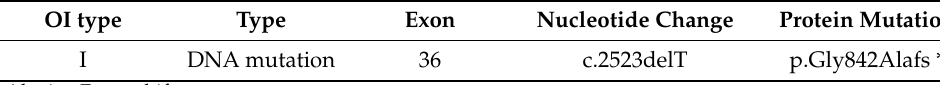
Table 3. Osteogenesis imperfecta cell lines with mutations in